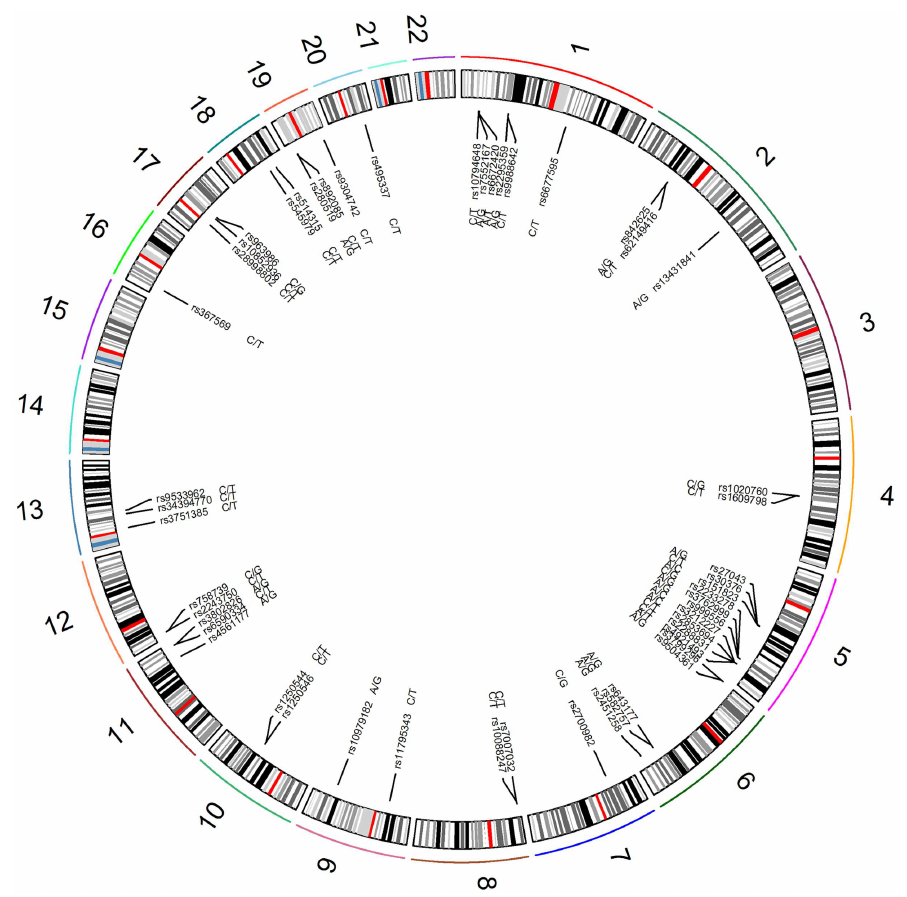
Fig 1. The 51 SNPs and alleles associated with psoriasis in the autosomal chromosome. The outmost lines with different colors represent chromosomes labledby 1–22, and ribboncolors in chromosomes assignedto Giemsa stain basedon the color scheme of the UCSC genome browserrepresent chromosome bands.